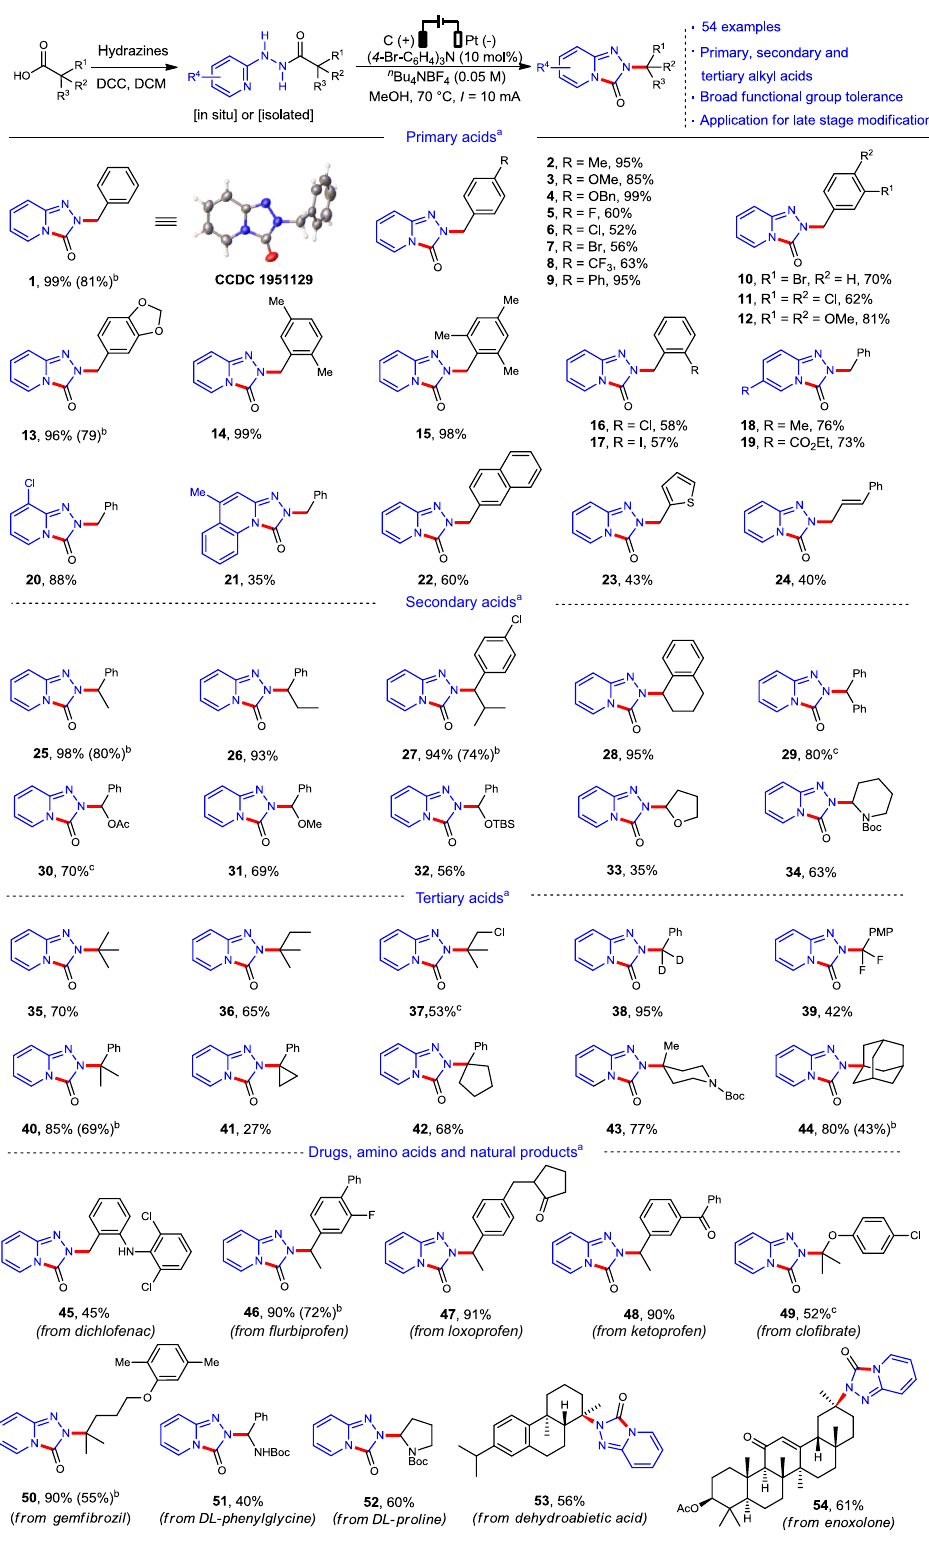
Fig. 2 Substrate scope and late stage modi fi cations via electrochemical rearrangement. a Reaction conditions: undivided cell, graphite rod ( ϕ 6 mm), Pt cathode (1 cm × 1 cm), hydrazide (0.3 mmol), n Bu 4 NBF 4 (0.5 mmol), MeOH (10 mL), 70 °C, 1.8 h (2.2 F/mol); b Yield for one-pot reaction with in situ hydrazide; c 40 °C. Ac acetyl, Boc tert -butyloxycarbonyl, PMP 4-methoxyphenyl, TBS tert